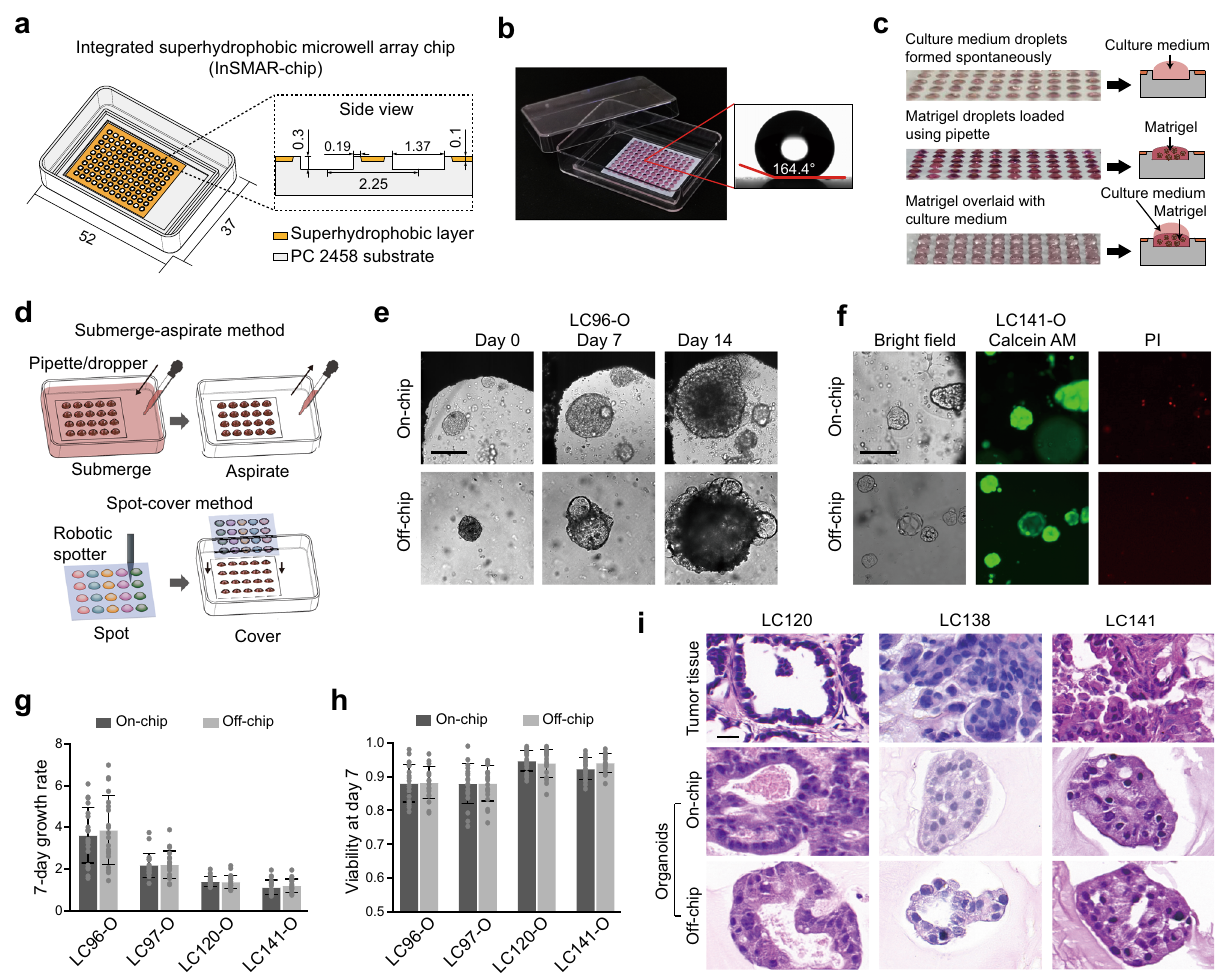
Fig. 3 Characterization of the integrated superhydrophobic microwell array chip (InSMAR-chip). a Schematics of the InSMAR-chip (left panel) and the cross-section view of the chip (right panel). b Photograph of an InSMAR-chip with a droplet array in the microwells. The contact angle of the superhydrophobic surface is >160°. c Photographs of the droplets in the microwells. (Top) The droplet array of culture medium formed spontaneously when the excess medium was aspirated out from the chip. (Middle) The droplet array of the Matrigel loaded into the microwells with an electronic pipette. (Bottom) The Matrigel droplets are overlaid with the culture medium by the spot-cover method. d Schematics of the reagent delivery methods on the InSMAR-chip: the submerge-aspirate method and the spot-cover method. e Images of LC96-O cultured on the InSMAR-chip (on-chip) and in the conventional microplate (off-chip), showing the continuous growths of LCOs in both conditions from days 0 to 14. Scale bar, 200 µ m. The experiments are repeated three times. f Bright- fi eld images of LC141-O at day 7 and fl uorescent images showing the viability of organoids (green: live cells; red: dead cells). Scale bar, 200 µ m. The experiments are repeated three times. g , h Comparison of the growth rates ( g ) and the viabilities ( h ) in four organoid lines indicating no signi fi cant difference between the LCOs cultured on-chip and off-chip ( n = 20 biologically independent cells. Data are presented as mean ± SD). i H&E stain of the parental tumor tissue and the corresponding LCOs cultured on the InSMAR-chip and in the conventional multiwell plate. Scale bar: 20 µ m. The experiments are repeated three